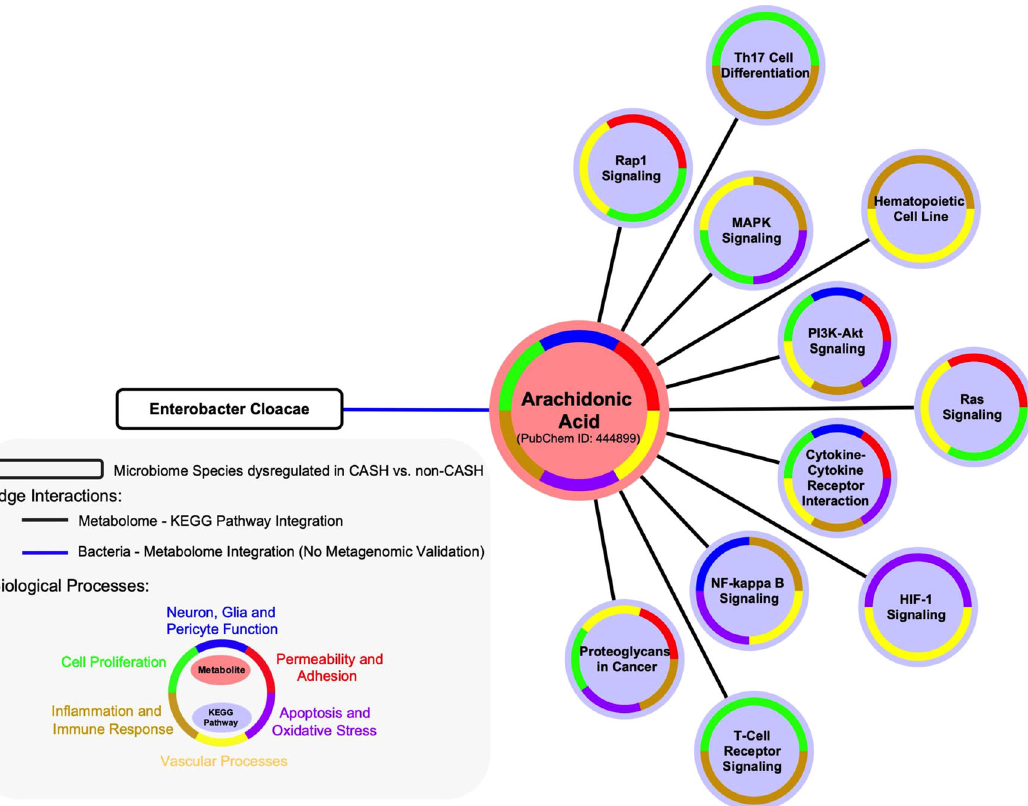
Fig. 4 Arachidonic acid links Enterobacter cloacae and 11 Kyoto Encyclopedia of Genes and Genomes (KEGG) pathways enriched across the differential proteome and transcriptome of cavernous angioma with symptomatic hemorrhage (CASH) patients. The integrative analyses draw a link between higher plasma levels of arachidonic acid and Enterobacter cloacae in CASH patients ( p < 0.05, false discovery rate [FDR] corrected; Bayes factor>3). Further analyses also identi fi ed 11 enriched-KEGG pathways with a role in cavernous angioma (CA) disease that overlapped between the differential plasma metabolome and proteome as well as the lesional transcriptome of CA disease. These 11 pathways were then categorized into six biological processes mechanistically related to CA disease ( p < 0.05, FDR corrected; Bayes